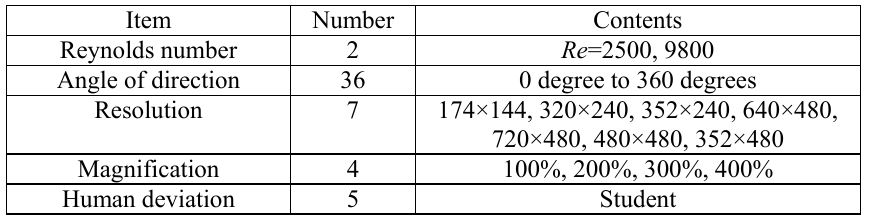
Table 1. Experimental